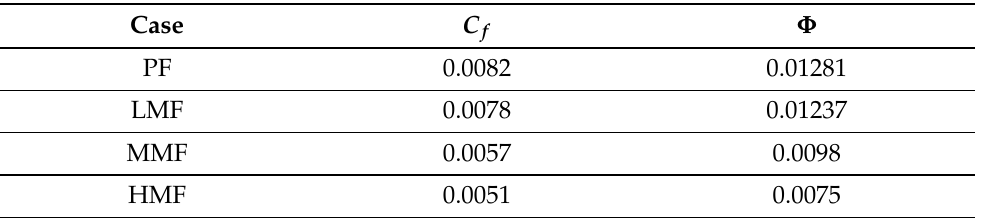
Table 11. Skin-friction coefficient C f and momentum source term Φ values for the LMF, MMF, and HMF cases. Φ values are time